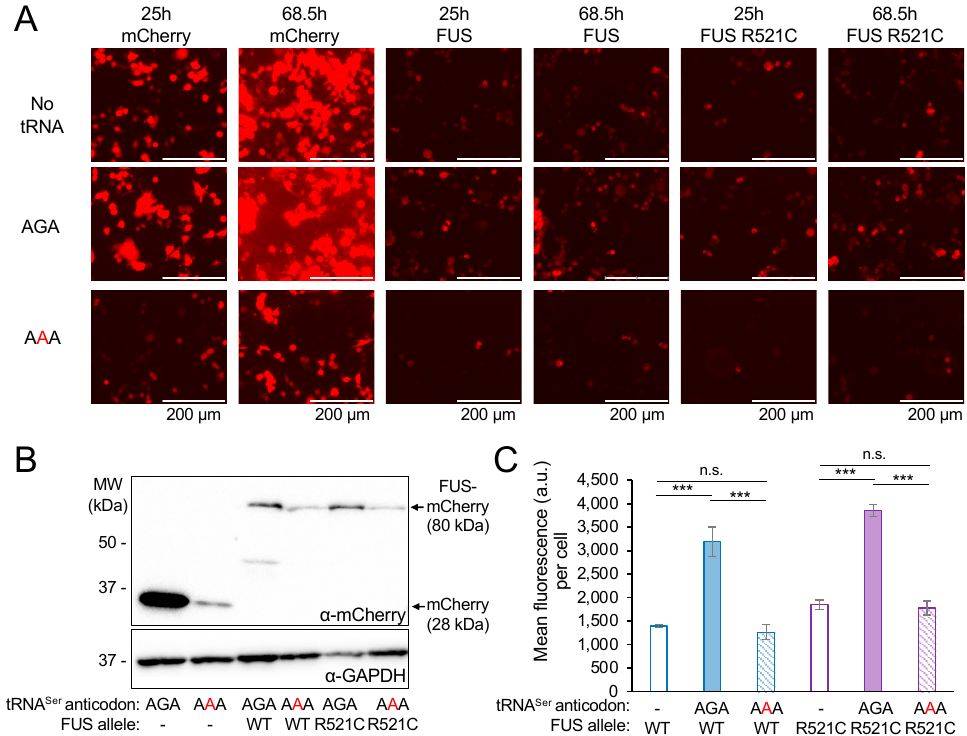
fluorescing cells were captured by live-cell fluorescence microscopy (RFP; ex. 531 nm, em. 593 nm) Figure 5. Total mCherry and FUS-mCherry protein levels in N2a cells co-expressing wild-type or beginning 24 h after transfection for a 43.5 h time lapse (see Figure S4). ( A ) Representative images mistranslating tRNA. N2a cells were transfected with a plasmid encoding no tRNA, tRNA Ser AGA